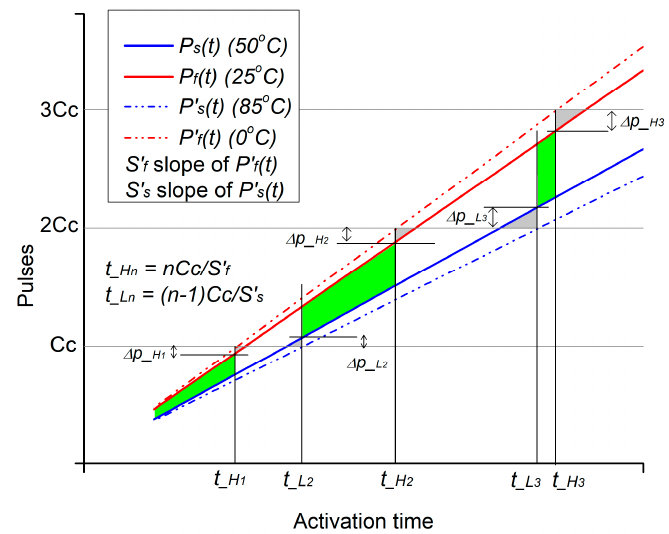
Figure 6. Prediction of RO pulses in longer runtimes. ( ∆ P_ Hn is the pulse difference between nCc and P f (t ) at t_ Hn ; ∆ P_ Ln is the pulse difference between ( n − 1) Cc and P s ( t ) at t_ Ln . Cc denotes counting capacity.)